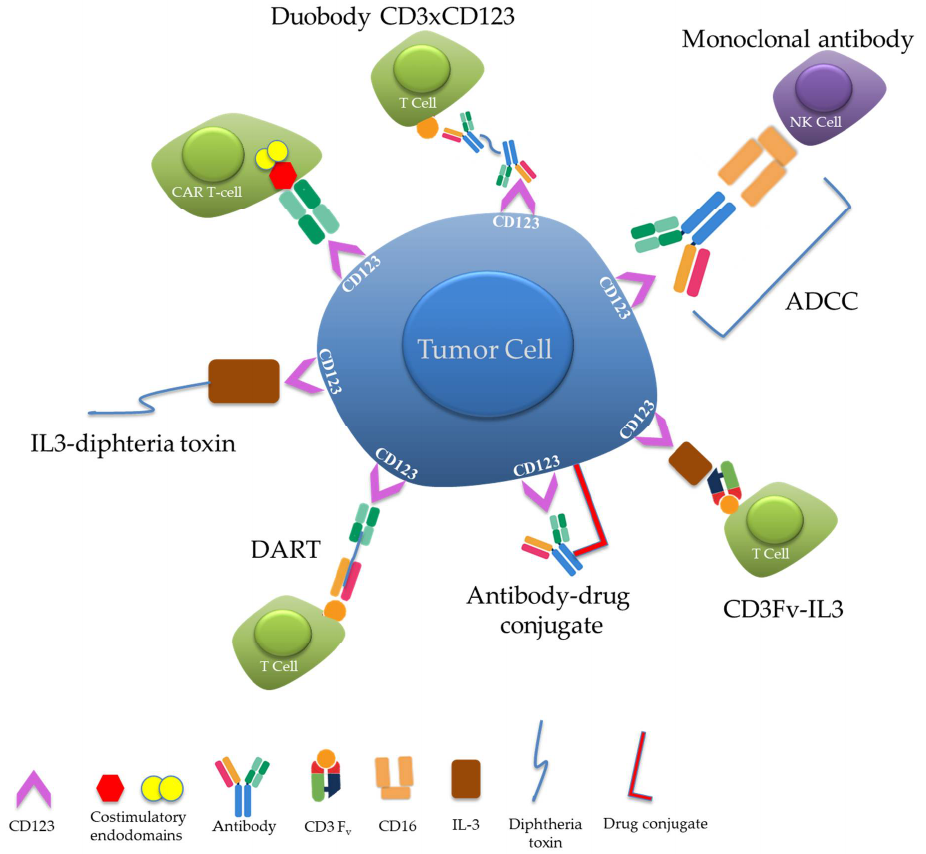
Figure 5. Schematic diagram of various CD123-targeted therapeutic constructs.